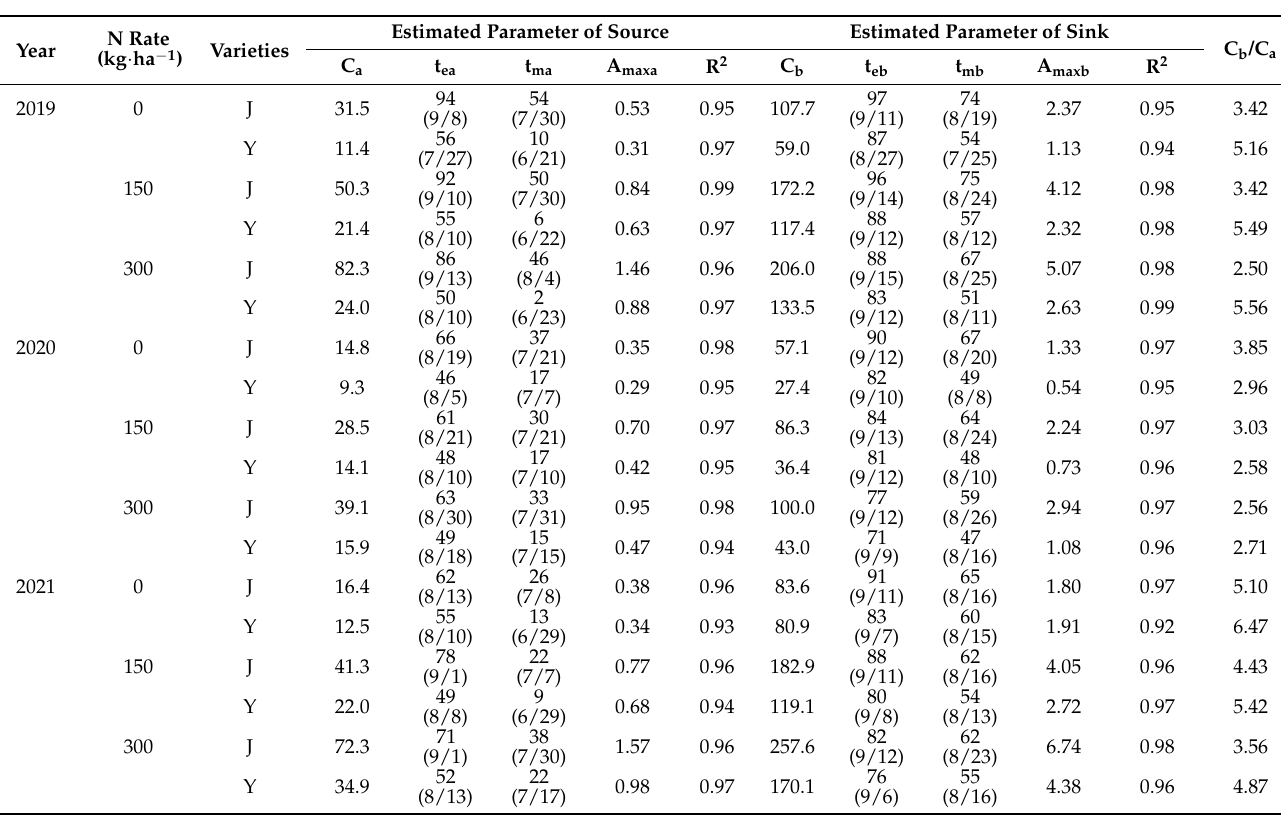
Table 4. Fitting parameter values for source and sink capacity and activity of two potato varieties at different nitrogen application rates.